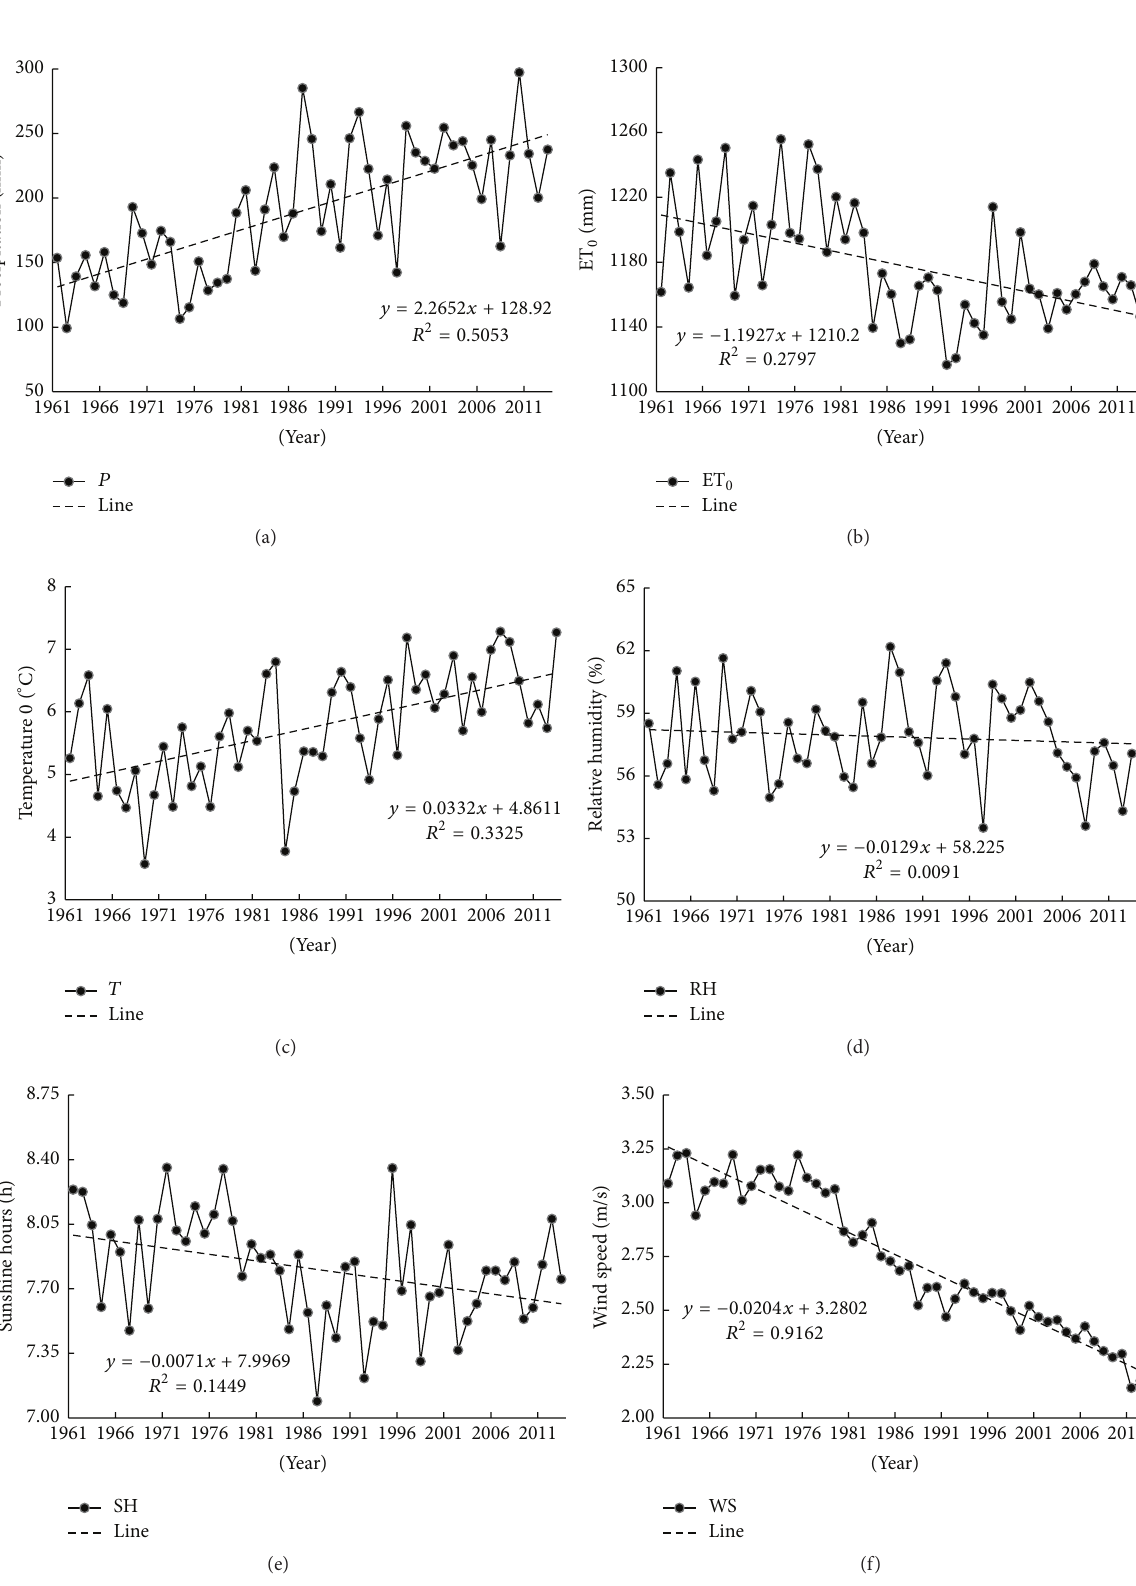
Figure 4: Time series and its trend associated with the six meteorological factors over North Xinjiang, China, during